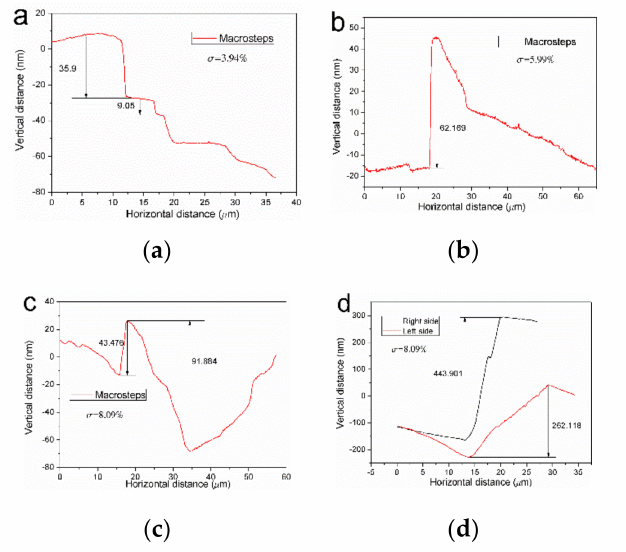
Figure 6. Steps profile images measured by AFM under di ff erent supersaturation: ( a ) σ = 3.94%; ( b ) σ = 5.99%; ( c ) ( d ) σ =